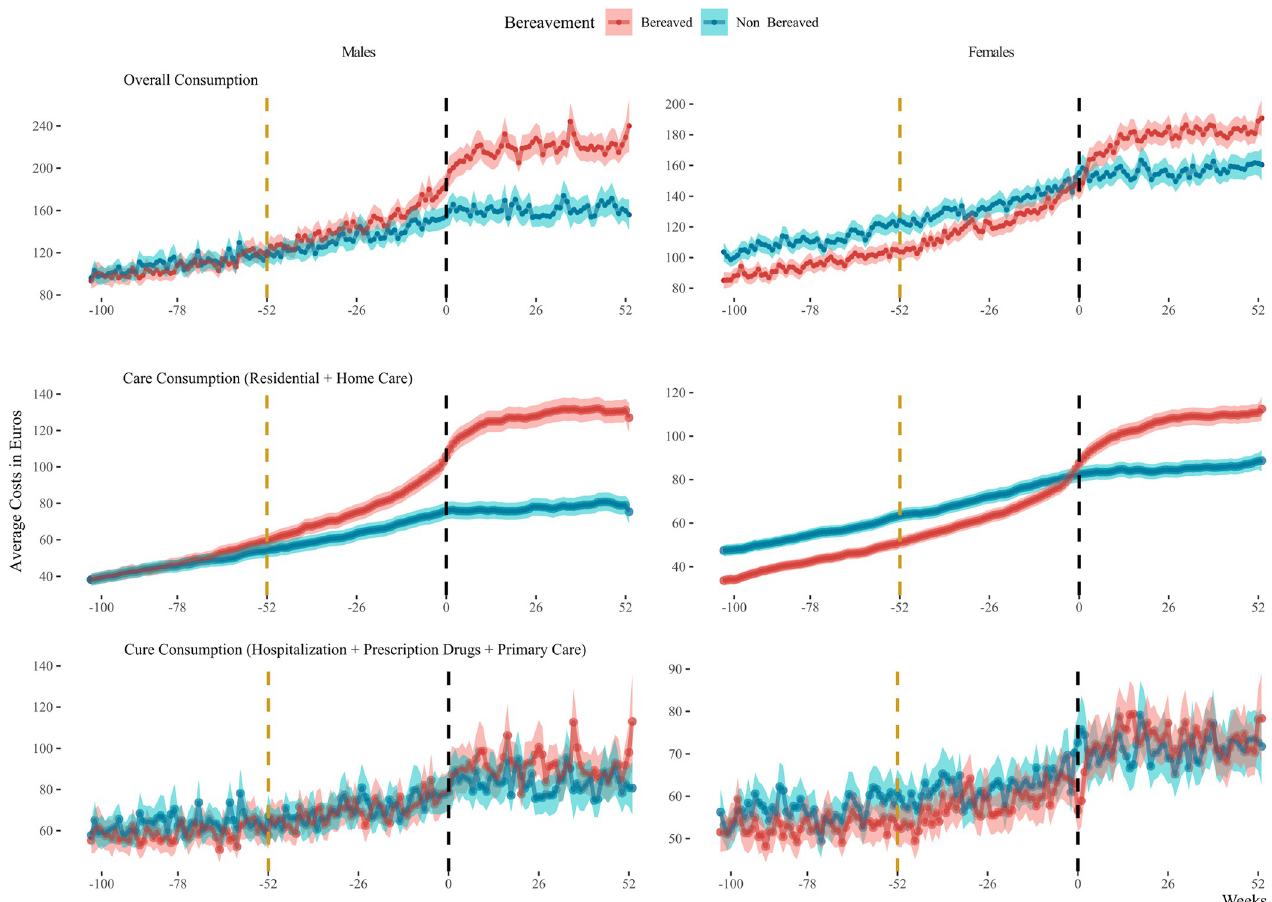
Fig 1. Weekly average expenditures in Euros stratified on bereavement status and sex. The red line represents individuals who suffered bereavement, the blue lines those who did not. Week 0 depicts the date of bereavement (black vertical line). Week -52 depicts the year before bereavement (yellow vertical line). The first column of the graph depicts the expenditures for males whereas the second one is for females. The first row illustrates the overall, aggregated health care expenditures of individuals (care- and cure- related), while the 2 nd and 3 rd row show the pattern specifically for care and cure expenditures, respectively.